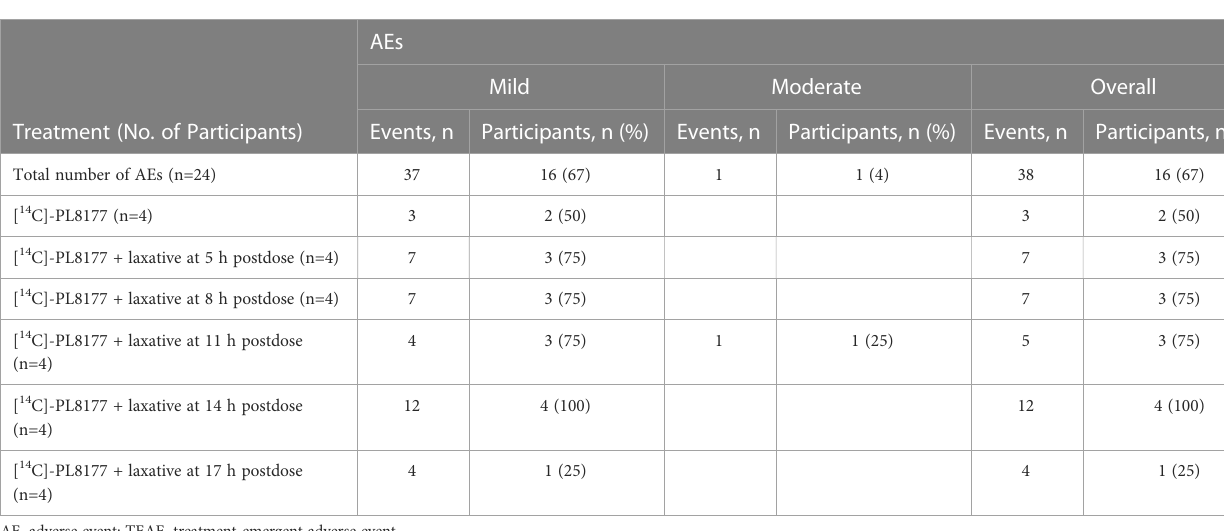
TABLE 4 Summary of TEAEs and severity in humans.